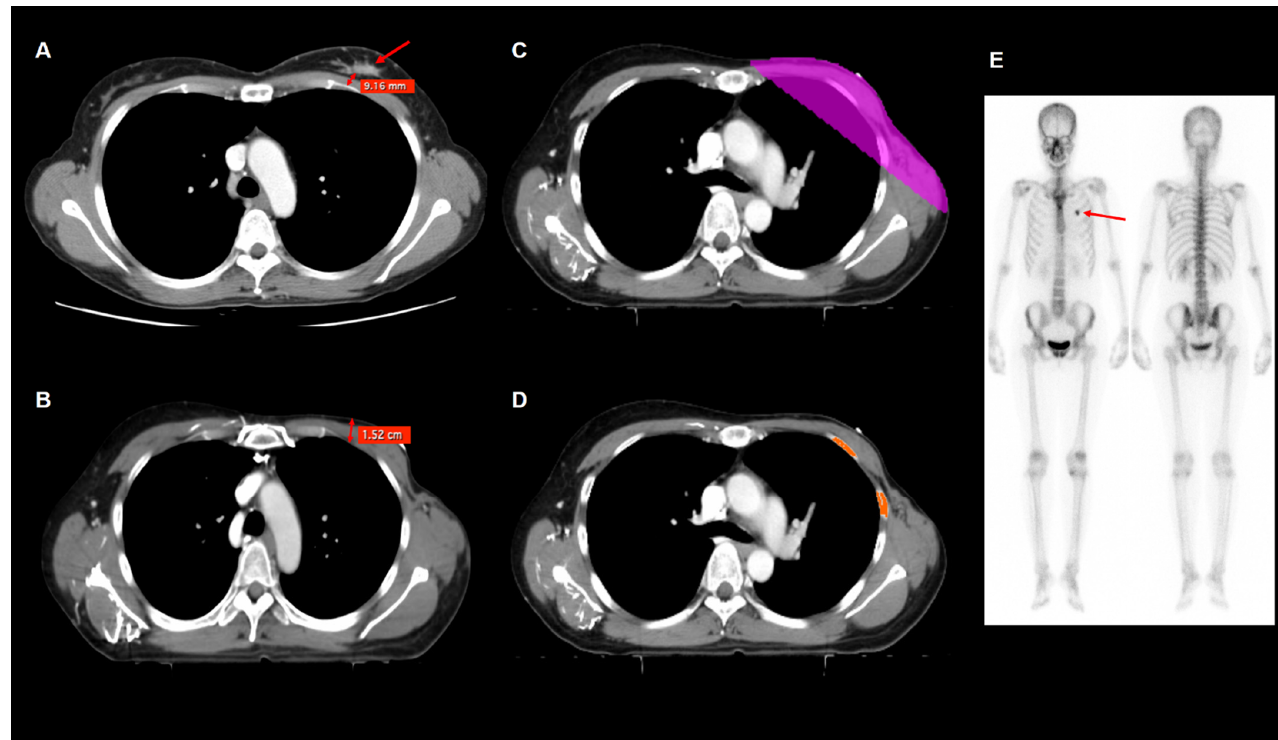
Figure 1. Preoperative contrast-enhanced CT image ( A ), radiotherapy simulation contrast-enhanced CT images ( B – D ), and bone scintigraphy images ( E ) showing an example of measurement of the tumor-rib distance, postoperative chest wall thickness, and V40 in a 43-year-old woman with left breast cancer. On preoperative CT images, the minimum distance from the margin of the primary tumor (arrow) to the rib was measured (0.9 cm), which was defined as the tumor-rib distance ( A ). On postoperative radiotherapy simulation CT images, the soft tissue thickness of the chest wall in the mid-clavicular line at the levels of the 2nd intercostal space (1.5 cm) was measured, as well as the 3rd and 4th intercostal spaces ( B ). Within the isodose area of 40 Gy ( C ), an area with a CT-attenuation range of 200–2000 HU in the ribs was selected ( D ), and the total volume of selected ribs was defined as the absolute rib volume receiving >40 Gy (V40), which was 41.0 cm 3 . On follow-up bone scintigraphy images ( E ) obtained 24.2 months after radiotherapy, RIRF was found in the anterior arc of the left 3rd rib (arrow).